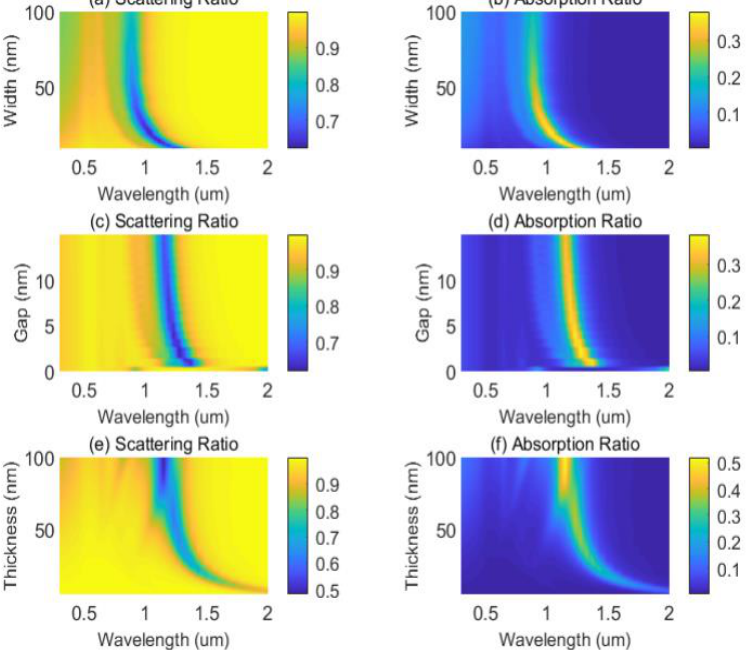
Figure 3. Scattering ratio and absorption ratio of the PGNB on a flat sapphire substrate depend on various geometrical parameters (width, gap size, and thickness of the PGNB) and incident wavelength. The incident light source, with a wavelength range between 0.3 μm and 2 μm and a polarization angle of 90 degrees (the polarization direction was oriented at the y -axis), was illuminated on the PGNB vertically. ( a , b ): the scattering ratio and absorption ratio of the PGNB depend on width of the nanobowtie and incident wavelength, respectively; ( c , d ): the scattering ratio and absorption ratio of the PGNB depend on the gap size between each gold nanoparticle and incident wavelength, respectively; ( e , f ): the scattering ratio and the absorption ratio of the PGNB depend on the thickness of the nanobowtie and the incident wavelength,